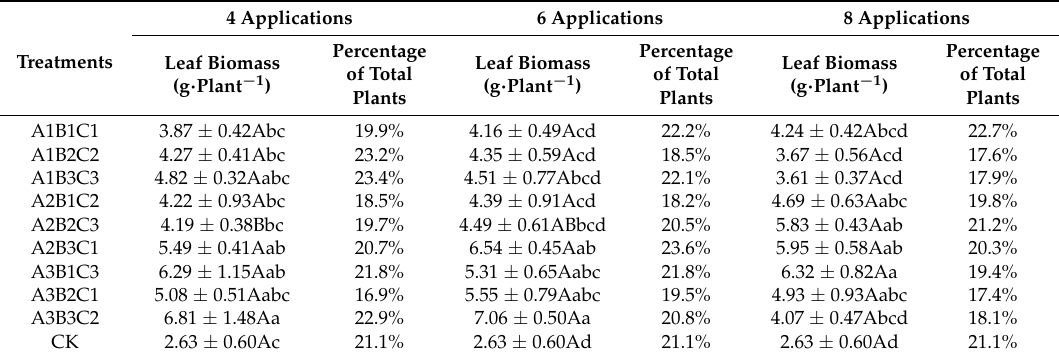
Table 9. Effects of different fertilization ratios and frequencies on leaf biomass. 4 Applications 6 Treatments